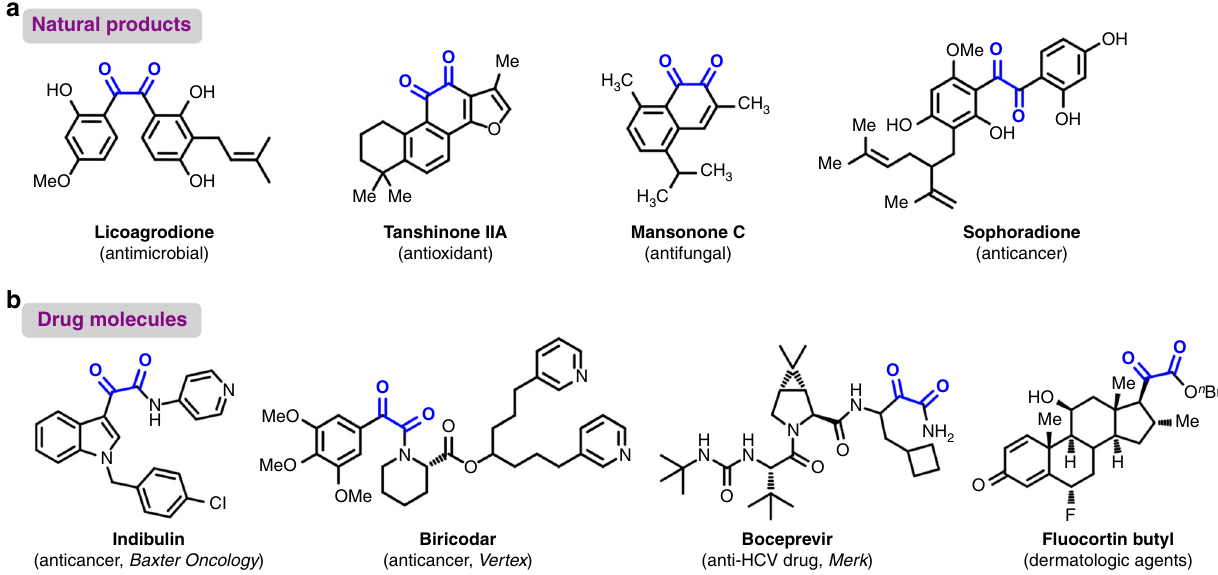
Fig. 1 Signi fi cant dicarbonyl-containing molecules. a Dicarbonyl-containing natural products. b Dicarbonyl-containing drug molecules